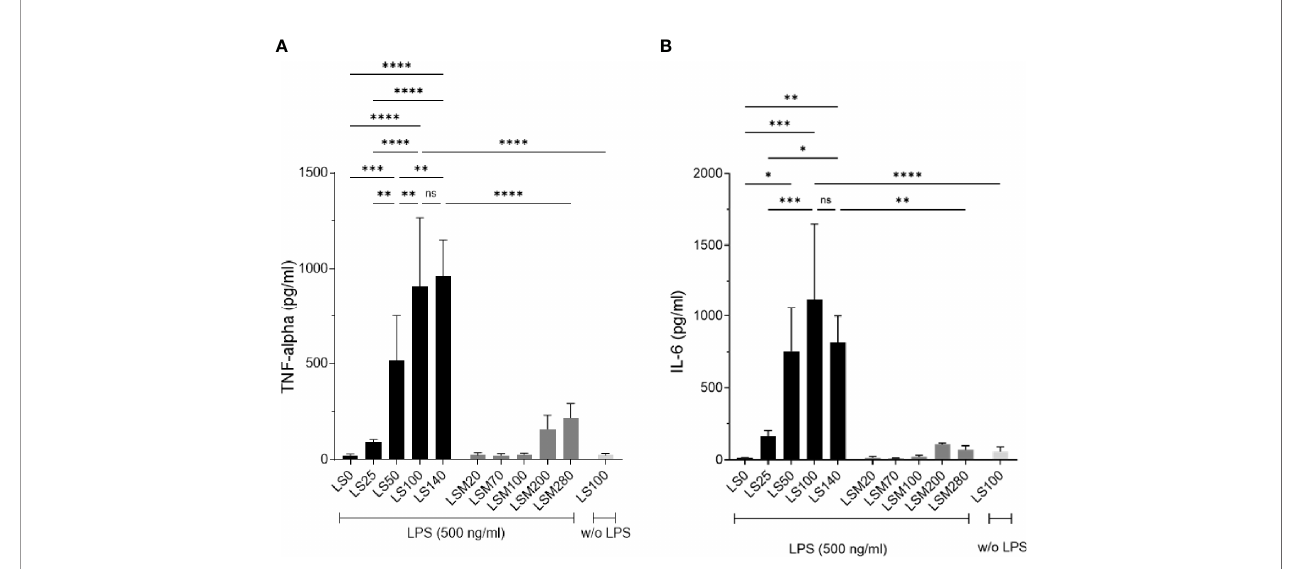
FIGURE 1 | Lowering NaCl concentration in cell culture medium inhibits TNF-alpha and IL-6 production of monocytes. Low salt (LS) medium was prepared as described elsewhere (24) and used as described in Table 1 . Murine monocytes from spleens of C57BL/6J mice were isolated and cultured in solutions under respective conditions for 24 h before TNF-alpha and IL-6 expression was induced by LPS (500 ng/ml) for 18 h. TNF-alpha (A) and IL-6 (B) concentrations were analyzed in the supernatants by cytometric-bead assays. * p < 0.05, ** p < 0.01, *** p < 0.001, **** p < 0.0001, ns = non-signi fi cant. p -values were calculated by one- way ANOVA followed by Bonferroni ’ s multiple comparisons test. All data were expressed as ± SEM from four independent experiments with technical duplicates.